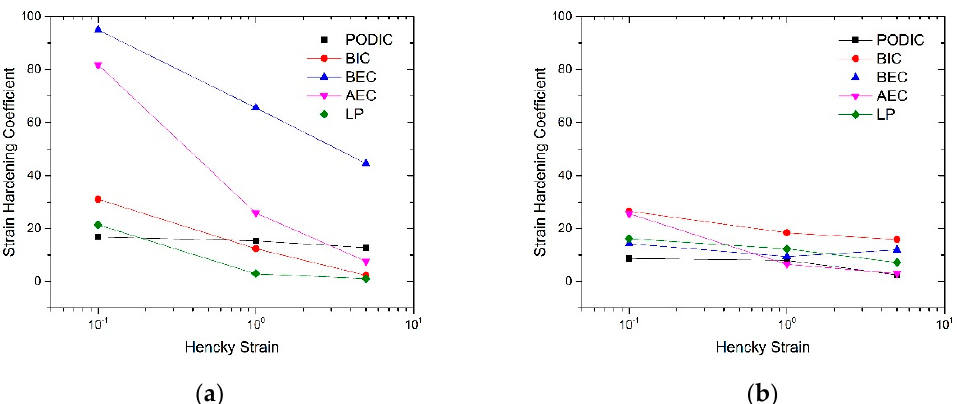
Figure 10. Strain hardening coefficient at different strains rates (0.1, 1, 5); modified at ( a ) 180 °C and ( b ) 240 °C.